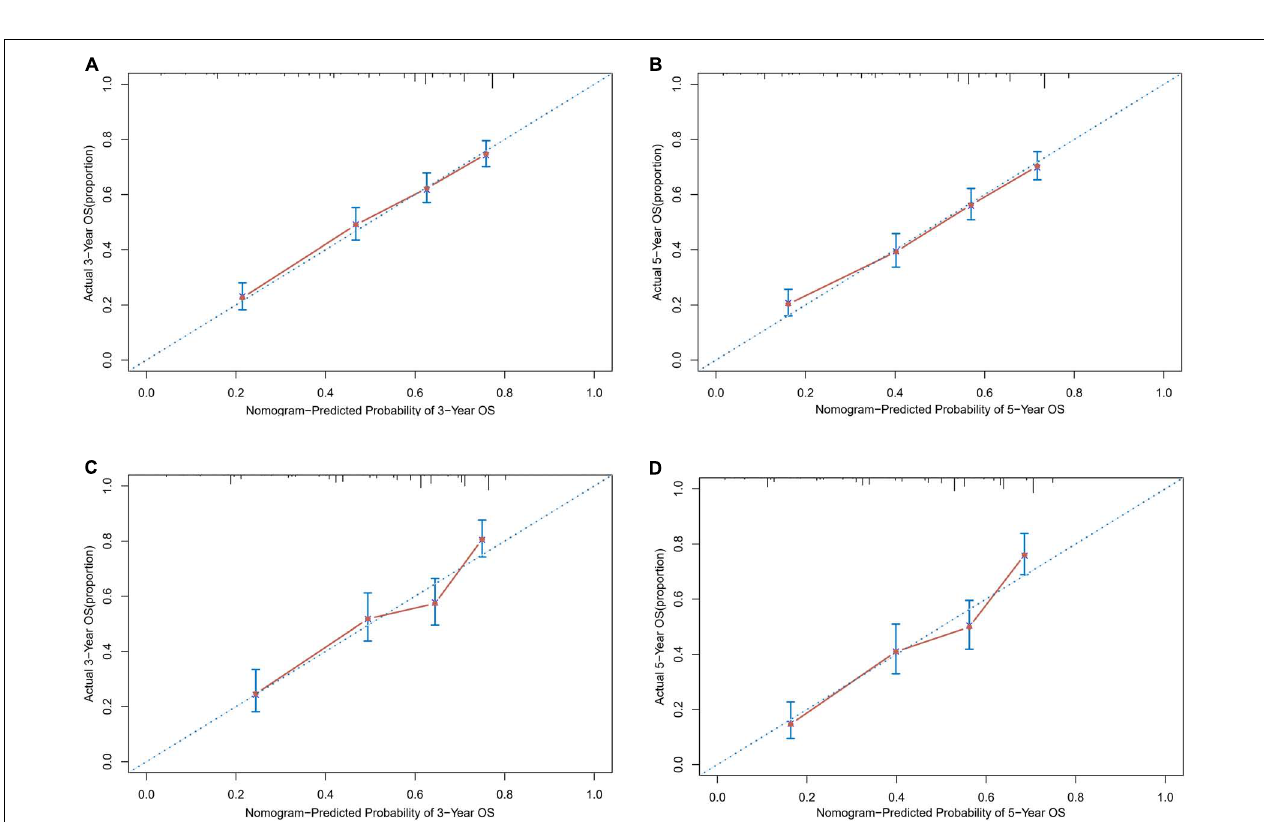
FIGURE 4 | Calibration plots of survival probabilities in patients with EGI DLBCL. (A) At 3-year and (B) 5-year in the development cohort. (C) At 3-year and (D) 5-year in the validation cohort.